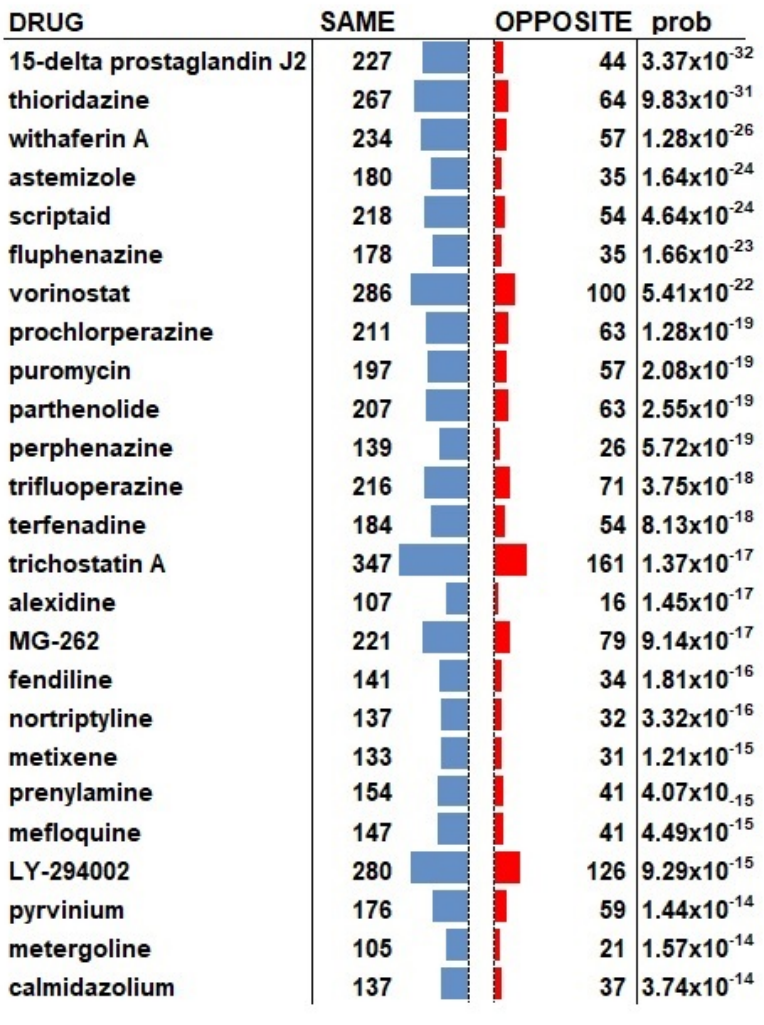
Figure 4. Drug-like compound expression profiles that correlate with AM630 driven expression changes in the core cell population. At the five standard deviations from the null level, there are 343 up and 348 down regulated genes. There is a substantial correlation with established anti-neoplastics and compounds with specific activity against GBM. Conspicuous amongst the correlating drugs are the six antipsychotic serotonin receptor antagonists: thioridazine, fluphenazine, prochlorperazine, perphenazine, nortriptyline and